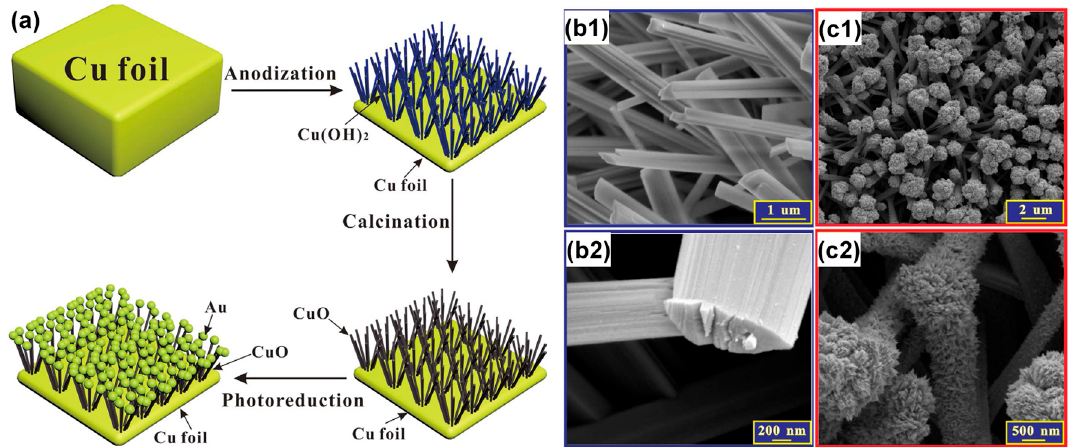
15 of 41 Figure 3. ( a ) Schematic illustration showing the fabrication of the 3D Cu foam–supported mesoporous Cu 2 O nanothorn array electrode and its function in the electrocatalytic oxidation of glucose; ( b ) Typical low ‐ and ( c ) high ‐ magnification SEM images of the Cu foam–supported Cu 2 O nanothorn array electrode; ( d ) Amperometric response of the Cu foam–supported Cu 2 O nanothorn array electrode toward the addition of 1 mM glucose and various 0.02 mM interfering species in the 0.1 M NaOH solution at 0.55 V vs. Ag|AgCl|KCl sat . Reprinted and adapted with permission from Reference [79]. Copyright American Chemical Society, 2015. 3.2.4. Heterogeneous Electrode Materials: Au ‐ and Cu ‐ Based Hydroxide or Oxide Interfaces Owing to its excellent electronic conductivity, Cu can replace Au as the support in the design of electrocatalysts. It also exhibits electroactivity properties, and is the most promising candidate for a carbon dioxide reduction reaction. In 2015, Li et al. [92] reported the first attempt in combining a Cu metal oxide and noble metal in a binder ‐ free style for fabricating non ‐ enzymatic glucose sensors. As is well discussed in Reference [58], the majority of existing synthetic methodologies require materials to be stabilized in a liquid or dispersed in a powder before using a binder, such as Nafion, to immobilize the NPs on a substrate (i.e., glassy carbon, carbon paper) prior to use. While the use of a Nafion ionomer contributes to the proton transport within the electrode materials, the use of such binders adds a layer of complexity to the fabrication process, and the degradation of binders results in the undesired loss of NPs and a subsequent decrease in the catalytic performance [58]. The preparation procedure for Au/CuO nanocauliflower is illustrated in Figure 4a. In a typical synthetic procedure, a copper foil was first electrochemically anodized in a conventional three ‐ electrode system to form Cu(OH) 2 nanowire arrays (at 25 °C in 3 M NaOH for 30 min under 10 mA ∙ cm ‒ 2 ) and then annealed at 180 °C for 1 h to convert Cu(OH) 2 to CuO. Subsequently, the obtained nanowire arrays were dipped into HAuCl 4 solution (pH = 6.0) under simulated solar light irradiation (100 mW ∙ cm ‒ 2 ) for 30 min for the direct photocatalytic reduction of Au(III), forming a unique nanocauliflower structure of Au/CuO. The SEM micrographs in Figure 4b show a dense layer of the Cu(OH) 2 nanowires covering the Cu foil substrate after anodization. After annealing, the length of the CuO nanowires was about 8–10 μ m [92]. Figure 4c depicts SEM images of the Au/CuO composite material where Au fully covers the entire CuO nanowire surface which may be ascribed to the